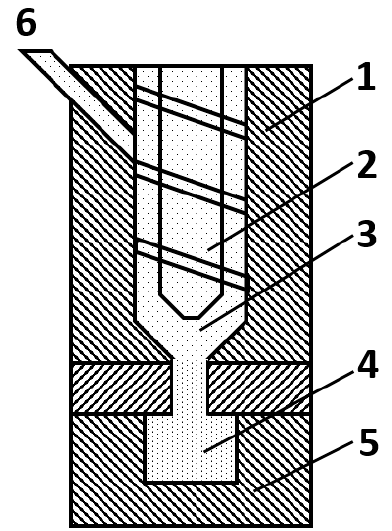
Figure 7. A scheme of a vertically oriented injection press: 1—heated housing, 2—screw, 3—molding mass, 4—green body, 5—mold, 6—molding mass loading.